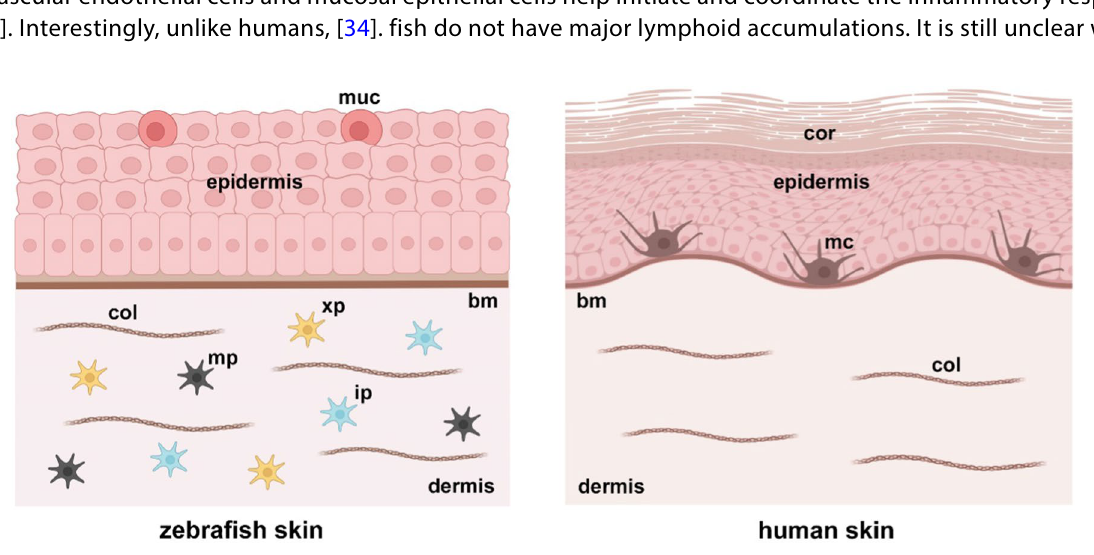
Fig. 1 Comparison between zebrafish and human skin. Bothzebrafish and human adult skin include a multi-layered epidermis, a basalmem- brane (bm) and an underling dermis containing collagen (col) fibers.Zebrafish epidermis contains mucous cells (muc), while human epider- mis has astratum corneum (cor) as outermost layer. Zebrafish pigment cells includexanthophores (xp), iridophores (ip) and melanophores (mp); human pigment cellsare represented by melanocytes (mc). Images created with